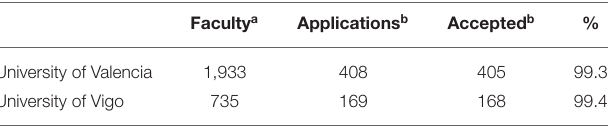
TABLE 6 | Success rate of the quinquenios at the University of Valencia and the University of Vigo. Faculty a